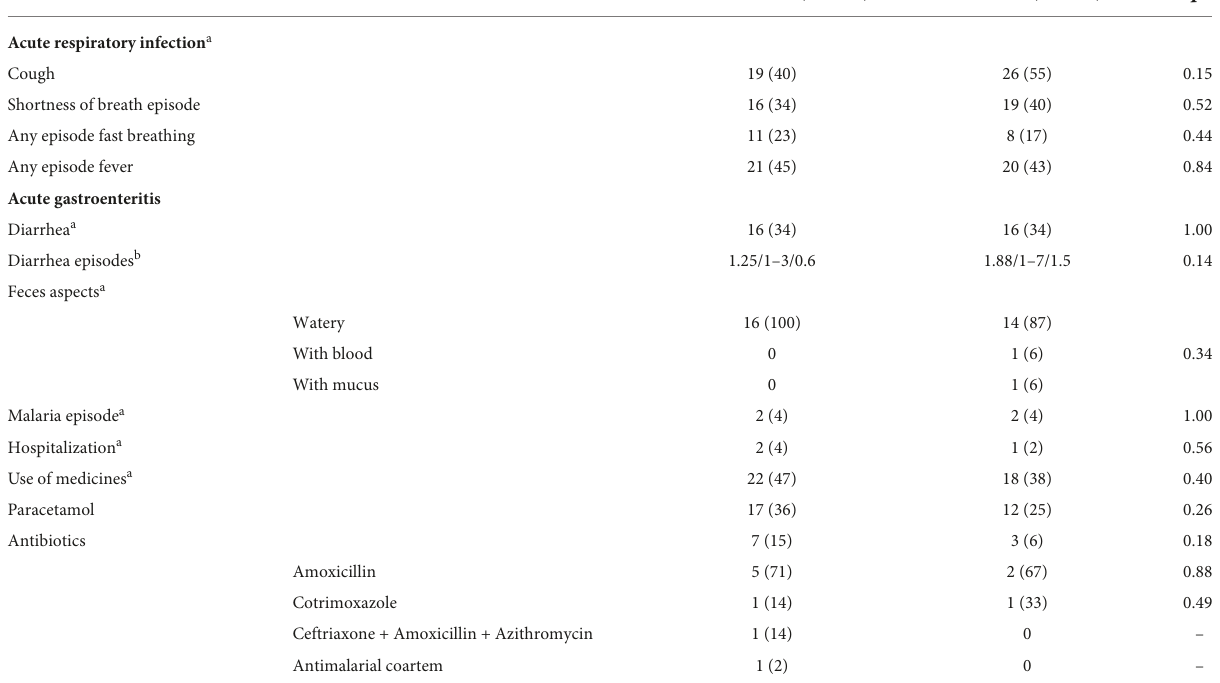
TABLE 2 Clinical outcomes developed from enrollment to